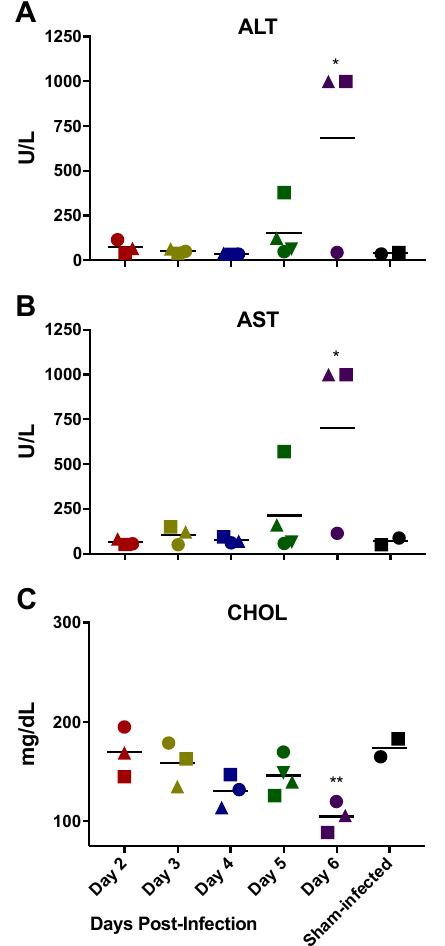
Figure 3. Blood chemistry values supportive of liver disease associated with RVFV MP-12 infection in STAT2 KO hamsters. Groups of hamsters ( n = 3–4) were sacrificed on the specified days post-infection and plasma biochemistry determined. One hamster in the day 6 group succumbed to infection prior to sacrifice and therefore could not be included in the analysis. Changes in concentrations of liver parameters ( A ) aspartate aminotransferase (AST); ( B ) alanine aminotransferase (ALT), and ( C ) cholesterol (CHOL) are shown. Unique symbols at each sacrifice day represent values for the same animals across all parameters. * p < 0.05 and ** p < 0.01 compared to day 2 RVFV MP-12-infected animals. The complete plasma biochemistry results are summarized in Supplementary Table S1.